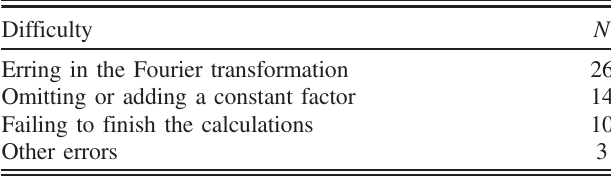
TABLE VIII. Difficulties in step E3: executing the procedure of solving the constants of the general